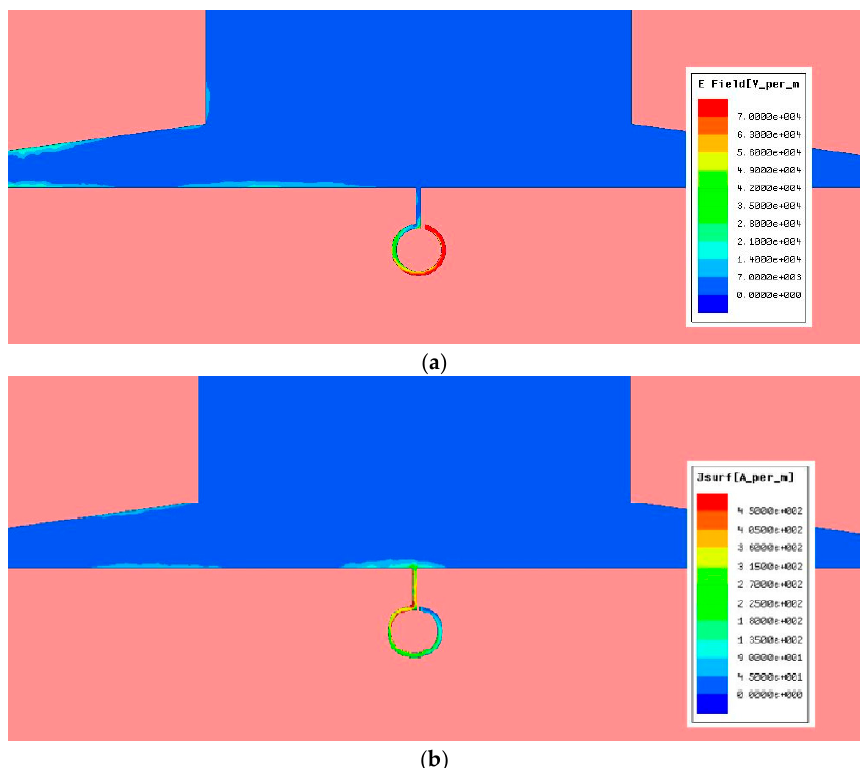
Figure 9. Distribution of the electric field ( a ) and current ( b ) for the CPW structure loaded with an ORR at the resonant frequency f 0 = 3.46 GHz.